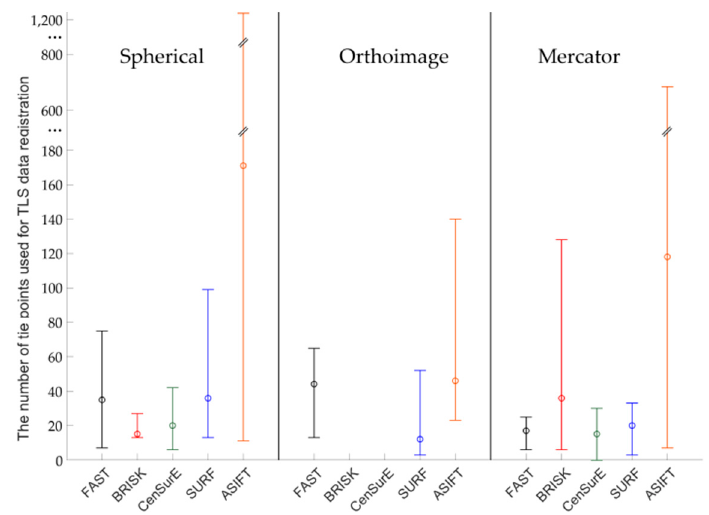
Figure 14. Diagram of the mean (circles), maximum, and minimum percentage of correctly detected and matched key points using blob (ASIFT, SURF, and CenSurE) and point (FAST and BRISK) detectors for rasters in the spherical projection, orthoimages, and the Mercator projection; Test Site IV.